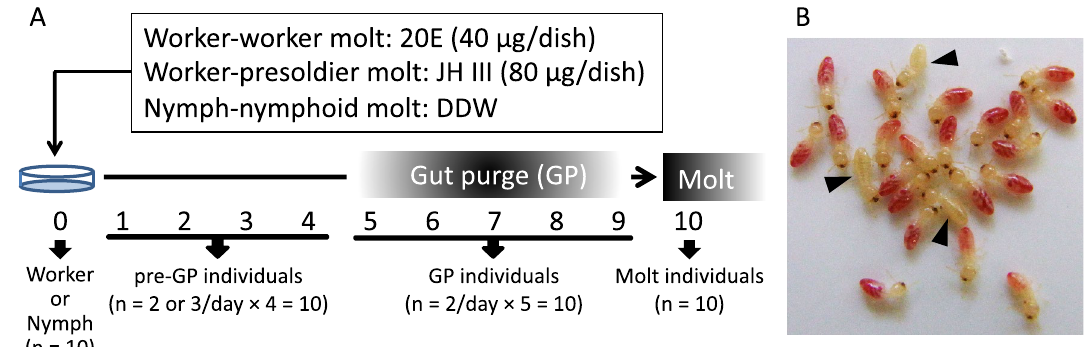
Figure 1. ( A ) Artificial induction method of each molt and time schedule for sampling of individuals examined. Each molt required a similar period of time. Ten individuals were collected from 4 different periods (worker or nymph, pre-GP, GP and molt stages) in each molt. To collect individuals before the gut purge (pre-GP), 2 or 3 individuals were sampled daily and mixed during the same period. Gut-purged individuals (GP-0, 1, 2, 3 and 4) were equally mixed for the GP individuals. Molt individuals were sampled within 24 h after each molt. ( B ) Examples of gut-purged workers (GP workers; arrowheads) with yellowish-white abdomens. Non-GP workers were used for the artificial induction treatment described in ( A